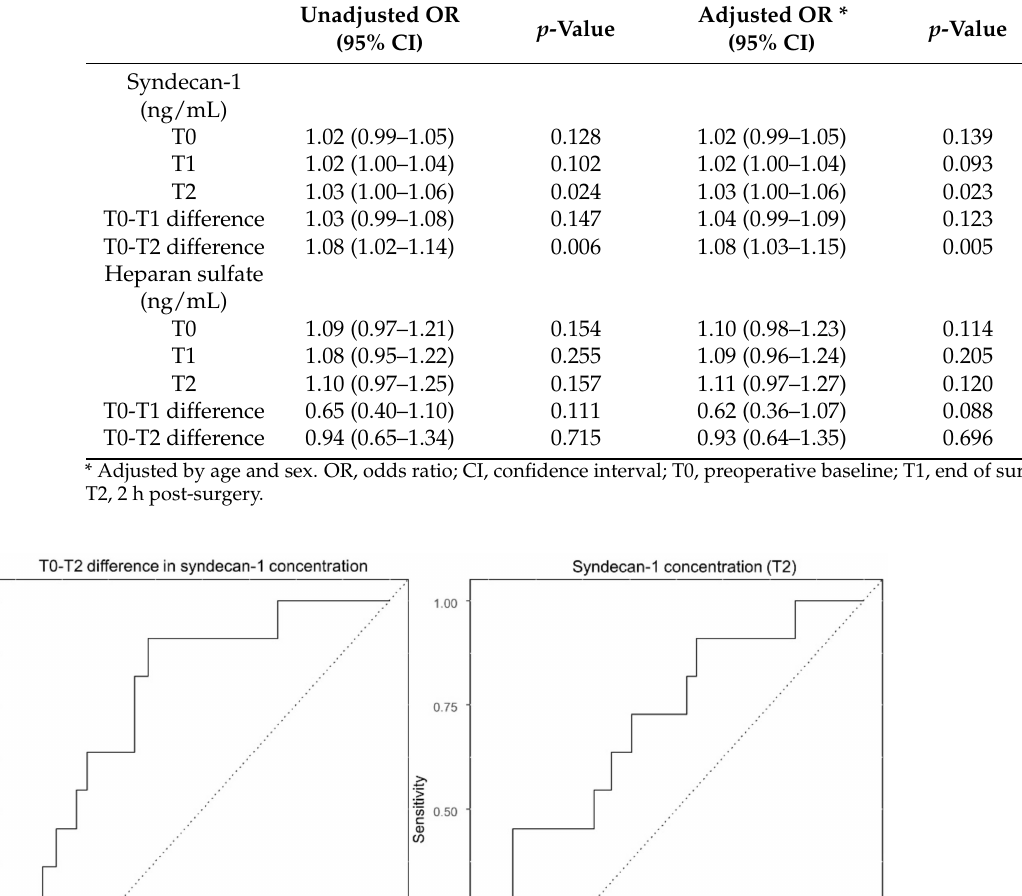
Table 4. Results of the logistic regression analysis to assess the associations between perioperative changes in endothelial glycocalyx concentrations and the occurrence of early postoperative outcomes.